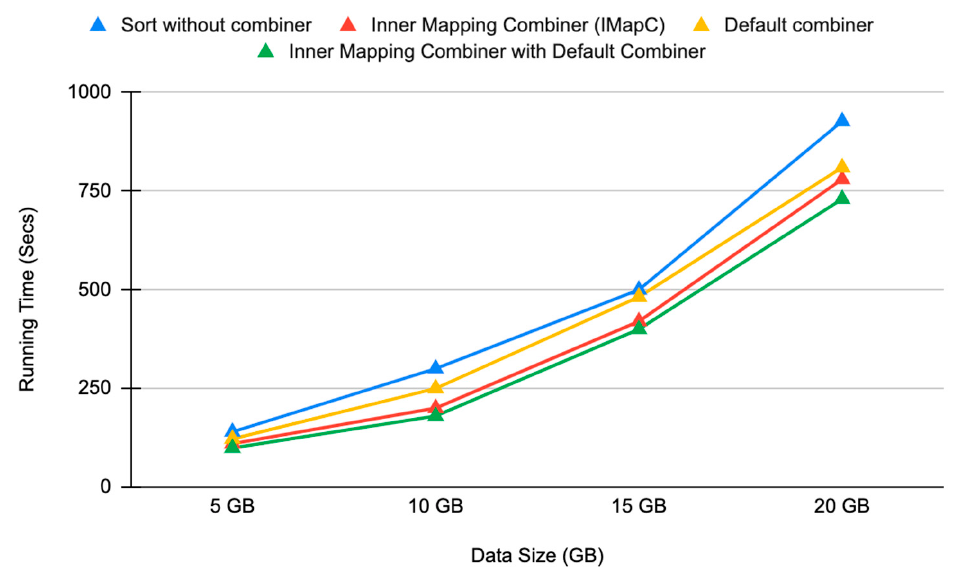
Figure 5. Execution time of Sort program for Inner Mapping Combiner (IMapC) over the Default Combiner and without the Combiner in Standard Hadoop.